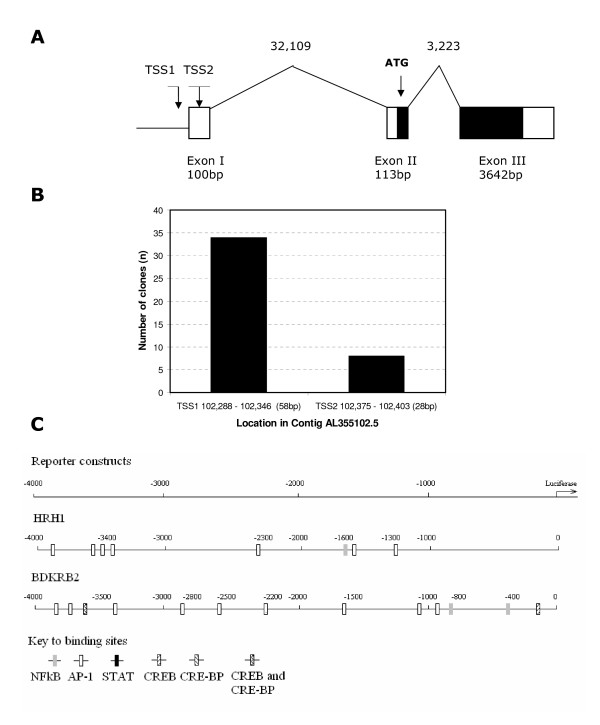
Identification of B2 Bradykinin Receptor gene transcription start site(s) and promoter region in Human ASM (A, B) and transcription factor analyses of core HRH1 and BDKRB2 promoter (C). Diagrammatic representation of the BDKRB2 genomic structure including identified exons and transcription start sites (TSS) in Human ASM (A) (Exon 1 5'boundary as described [42]). Number of pCR-4 clones clustering to the two potential transcription start sites (B). Data represents combined data from two Human ASM donors. Relevant transcription factor binding sites identified within the 4 kb of the core promoter of HRH1 and BDKRB2 genes by at least two of the four databases utilised (C).